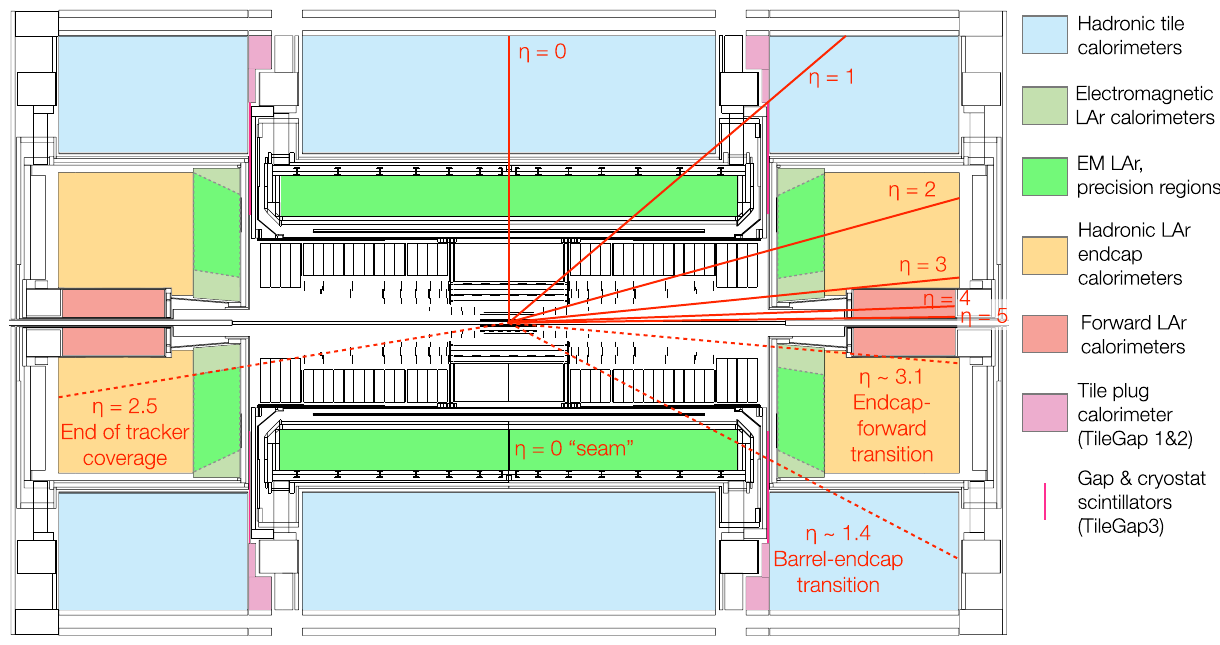
Fig. 1 Layout of the ATLAS calorimeters with pseudorapitidy ( η ) val- ues marked for reference. The inner detector systems can be seen in black-and-white in the center of the diagram; tracking is provided up to η = 2 . 5. The electromagnetic (EM) barrel and endcap calorimeters are shown in green. The EM barrel has consistent performance throughout, but has a seam in the construction at η = 0 which can impact jet energy resolution. The EM endcap has a precision region marked in darker green and an extended region in light green, and the transition from one to the other around η ∼ 2 . 5 involves a dramatic change in the material